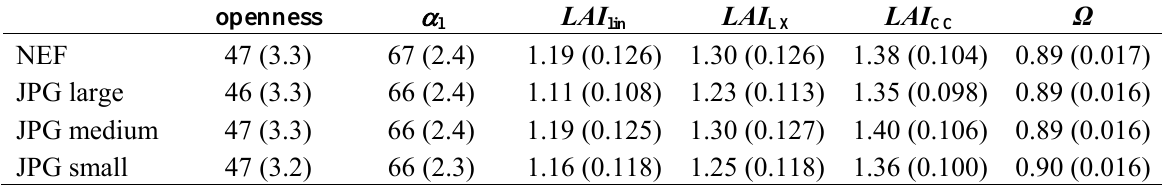
Table 3. Canopy openness, mean leaf inclination angle ( α ( LAI ), leaf area index calculated after Lang and Xiang [40] ( LAI lin corrected for foliage clumping after Chen and Cihlar [42] ( LAI for each full-frame fisheye image type collected with the Nikon D80 DSLR camera. Each data point is mean and standard error (in brackets) of the seven forest